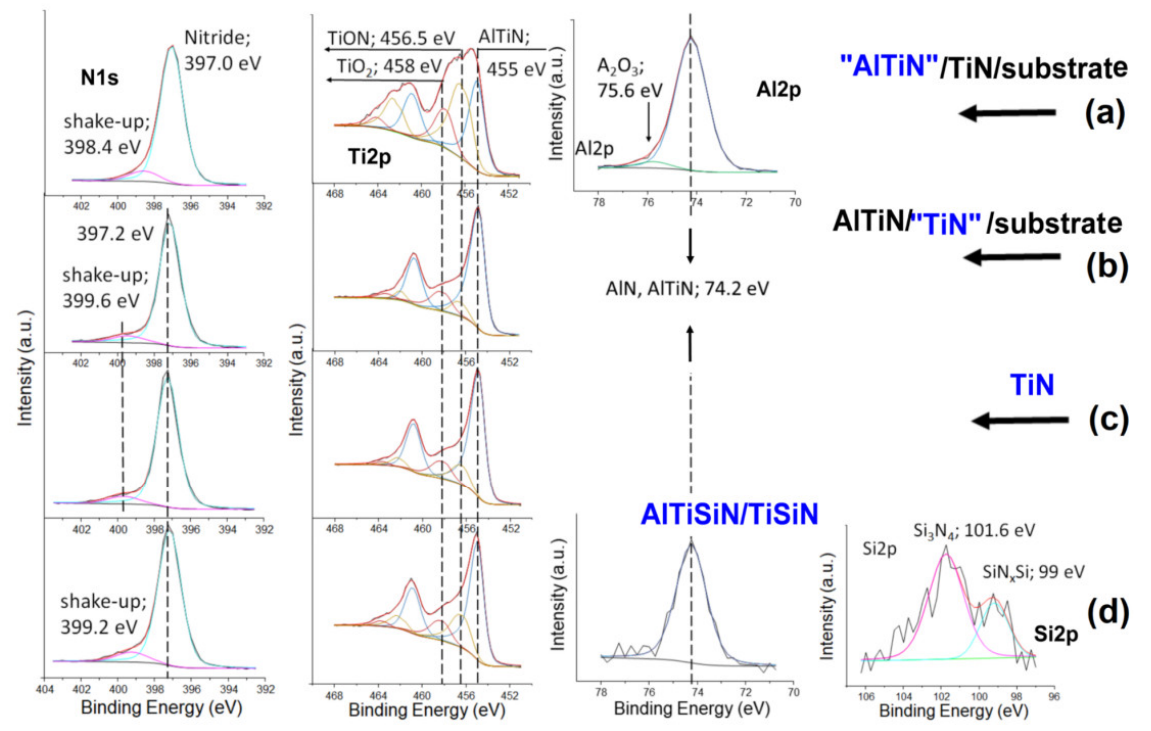
Figure 11. The N1s, Ti2p, Al2p and Si2p core lines recorded from the tested coatings—( a ) “Al- TiN”/TiN, ( b ) AlTiN/”TiN”, ( c ) TiN and ( d ) AlTiSiN/TiSiN. The presented spectra were chosen from the inner region of the tested coatings marked by an arrow in Figure 10. The blue color indicates the type of shell for which the core lines are presented